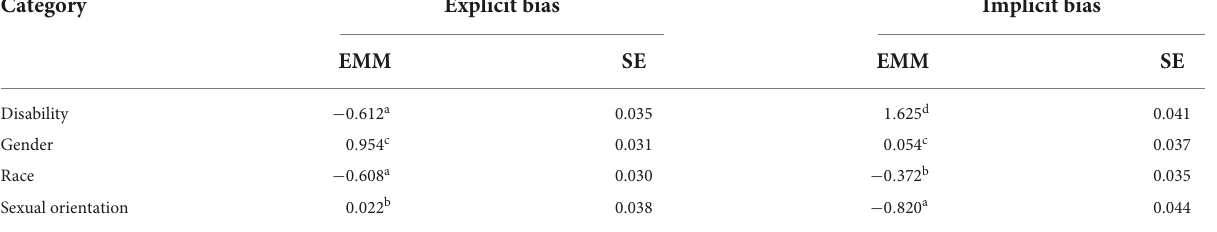
TABLE 4 Differences in explicit and implicit bias among